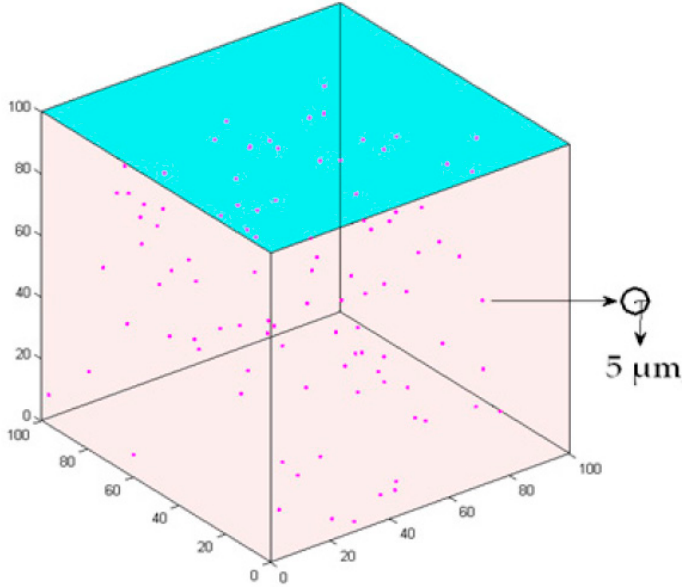
Figure 1. 3D cell growth model. Axes x, y and z represent the length, width and height, respectively. Each sphere represents a cell.